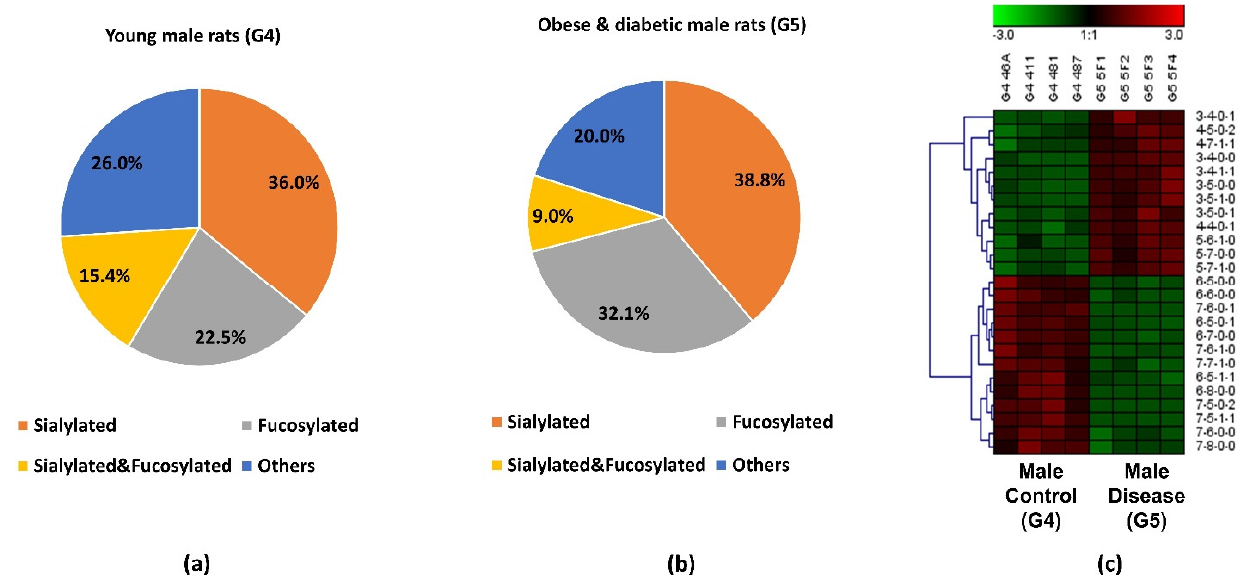
Figure 5. Distribution changes of different N -glycan types from ( a ) young male control (G4) and ( b ) obese and diabetic male (G5); ( c ) Heatmap of 25 N -glycans that exhibited significant expression changes between G4 and G5. In the heatmap, each row represents an individual significant N -glycan. The red color of the cell denotes a high relative abundance, while the green color represents a low relative abundance of the N -glycan.